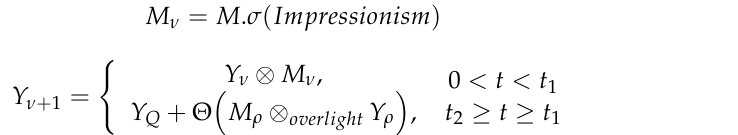
Figure 25. The working diagram for time variant lighting of historical building façade (tribute to impressionism). The end of the diagram has been deliberately omitted.